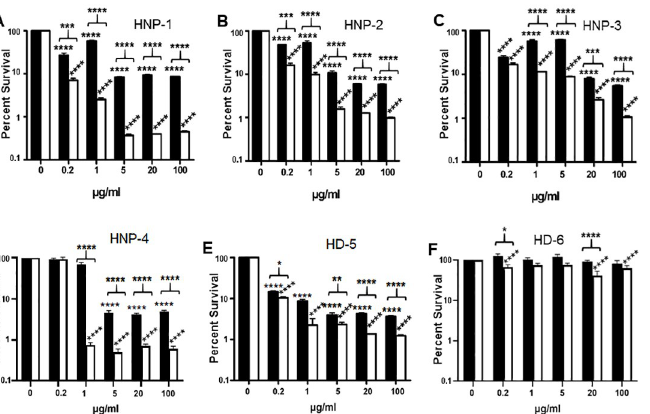
Fig 1. Human alpha defensins have reduced bactericidal activity against an encapsulated B . anthracis strain compared to an isogenic non-encapsulated strain. Encapsulated WT and non-encapsulated capA mutant bacilli were exposed to HNP-1 (A), HNP-2 (B), HNP-3 (C), HNP-4 (D), HD-5 (E), and HD-6 (F), at varying concentrations in triplicate tubes, incubated at 37˚C in 5% CO 2 for 2 h, and plated for CFU. Control tubes without defensins were incubated and plated in parallel. Survival percentages were determined by calculating the ratio of CFU with/CFU without defensin. Black bars represent WT and white bars represent capA mutant. Three experiments were run (n = 3). Results expressed as the mean + SEM from a representative experiment are shown. Significance of killing was determined by ANOVA with Tukey’s post-hoc test. Significance of differences in survival between the WT and capA strains was determined by two-tailed Student’s t-test ( � p < 0.05, �� p < 0.01, ��� p < 0.001, ���� p < 0.0001).